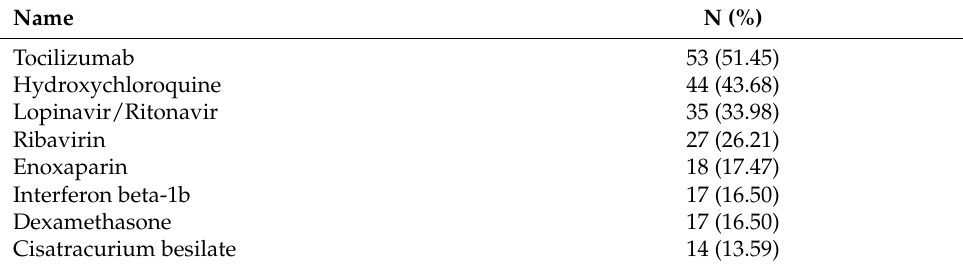
Table 2. List of drugs in short